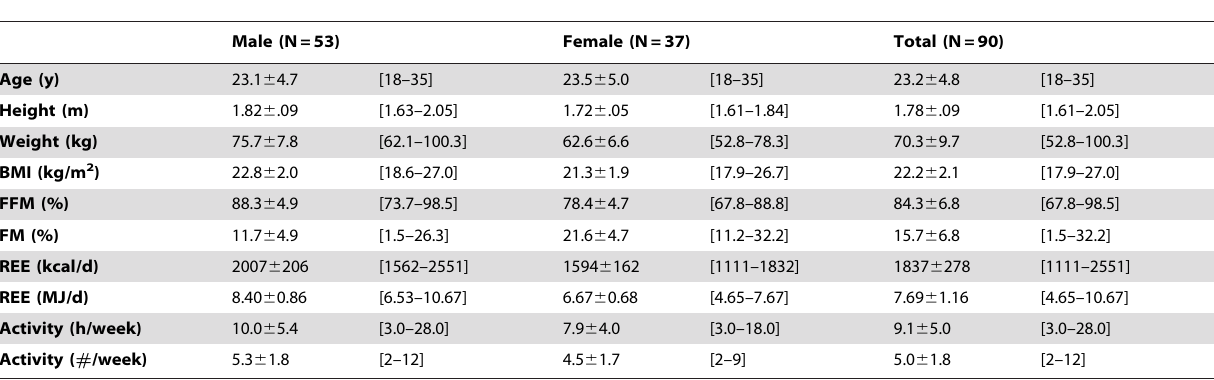
Table 2. Subjects characteristics: mean 6 standard deviation [range].